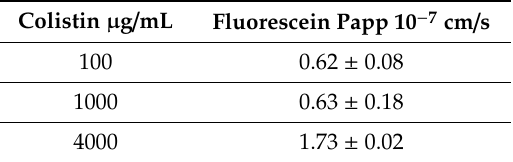
Table A2. Apical-to-basal fluorescein permeability measured across a Calu-3 cell epithelium model after 6 h of incubation of the apical side monolayer in the presence of di ff erent COLI concentrations.